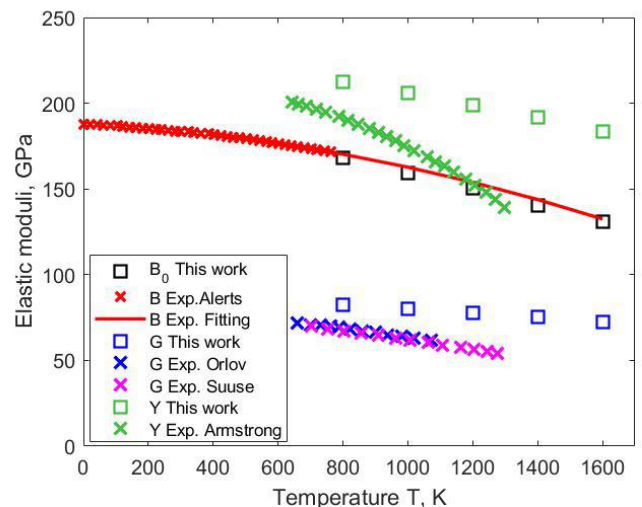
Figure 6. Temperature-dependent elastic moduli of paramagnetic nickel. Experimental data are from [15,47–51].